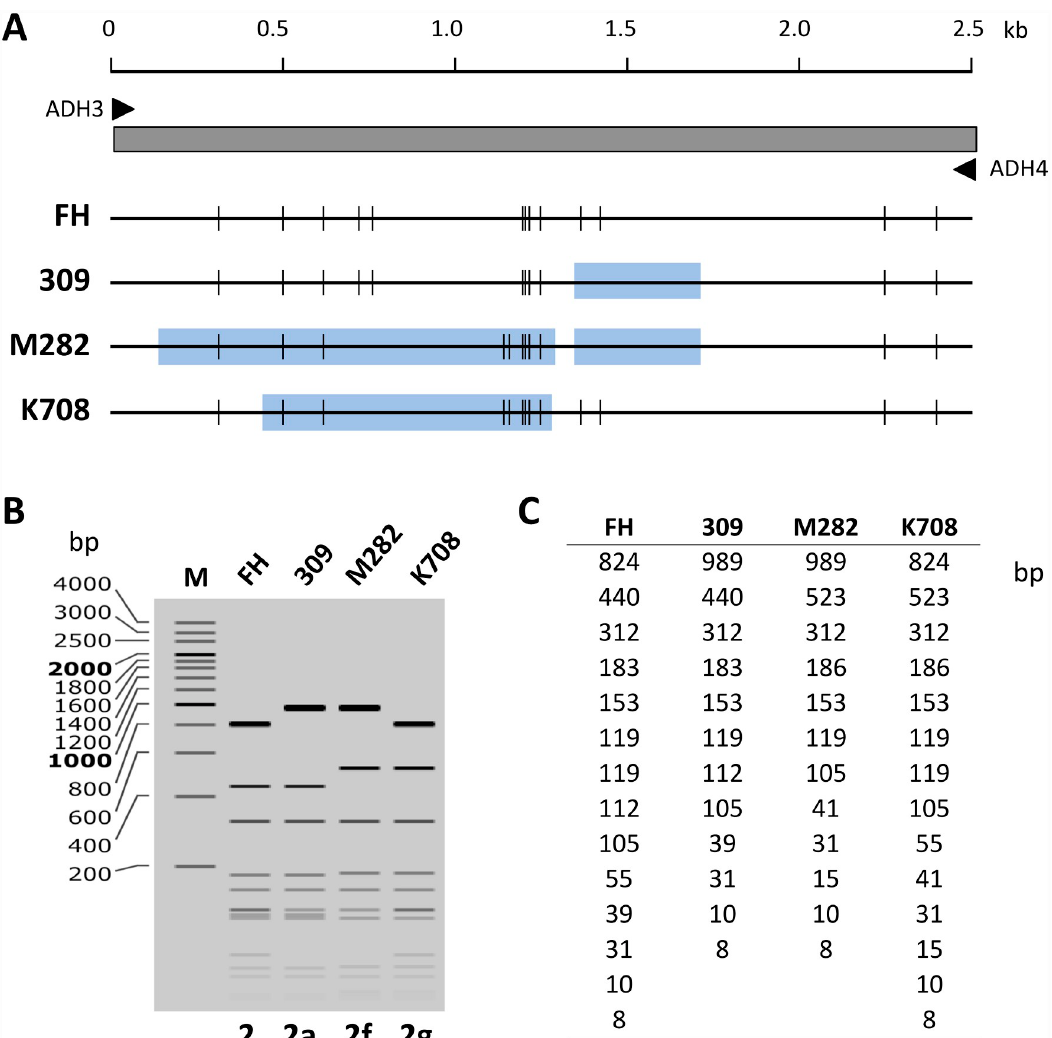
Fig 3. Novel p1 gene sequence variations in strains M282 and K708. (A) Schematic diagram of the PCR amplicons obtained using the primers ADH3 and ADH4, containing RepMP2/3 region of the p1 gene. Predicted Hae III sites within the amplicons from strains FH (type 2), 309 (type 2a), M282 (type 2f), and K708 (type 2g) are shown. Light blue boxes indicate the regions of sequence variations compared to that of the type strain FH. (B) Simulated pattern of 2% agarose electrophoresis of Hae III-digested amplicon fragments predicted by using the p1 gene sequences (GenBank accession nos. CP010546, AP012303, LC390170 and LC385984). The pattern was calculated by using SnapGene software version 4.2.3 (Snapgene.com). (C) Theoretical size of Hae III-digested amplicon